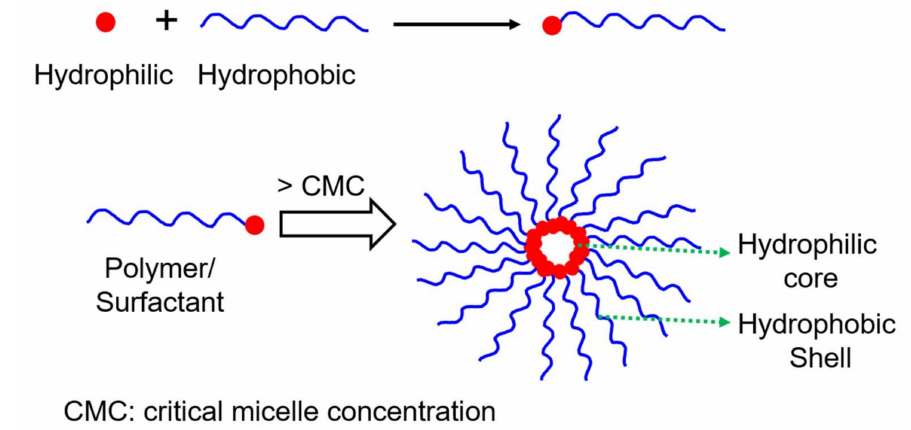
Scheme 2. Illustration of self-assembly of a polymer or surfactant into an inverse micelle.